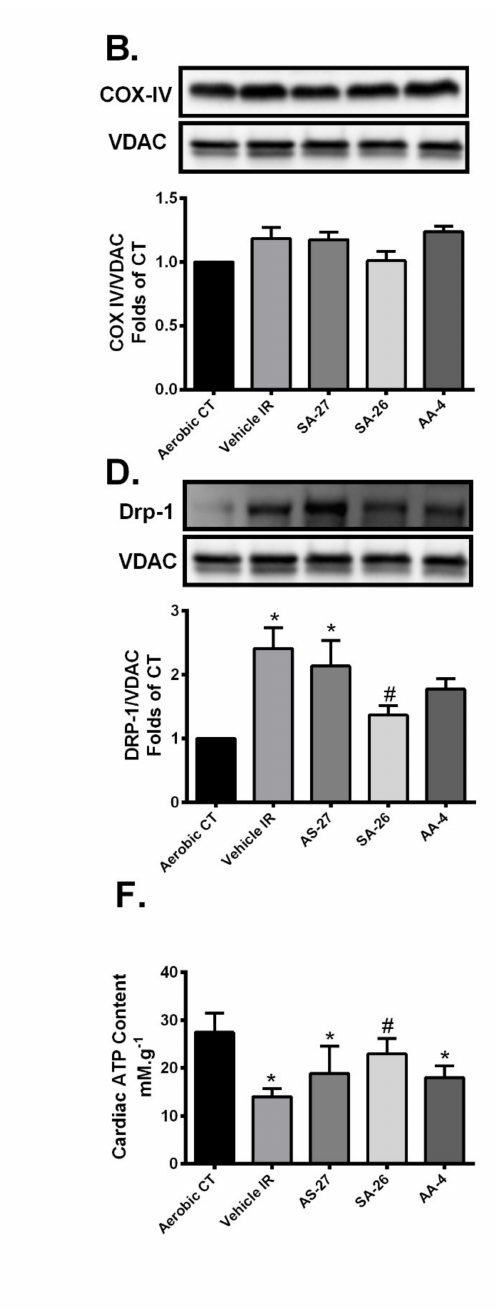
Figure 4. Perfusion of hearts with SA-26 preserved mitochondrial integrity and function under IR insult. Representative immunoblots and densiometric quantification of the mitochondrial protein expression of ( A ) succinate dehydrogenase subunit A (SDH-A), ( B ) cytochrome c oxidase subunit IV (COX IV), ( C ) citrate synthase (CS), ( D ) dynamin-related protein 1 (DRP1) and (E ) optic atrophy 1 (OPA1) proteins observed in mice hearts following 30 min ischemia and 40 min reperfusion. All expressions were normalized to VDAC loading control. ( F ) Cardiac ATP levels were measured in mice hearts using a fluorometric based assay kit assessed following 30 min ischemia and 40 min reperfusion. Values represent mean ± SEM, * p < 0.05 vs. Aerobic CT, # p < 0.05 vs. Vehicle IR ( n = 4–5 per